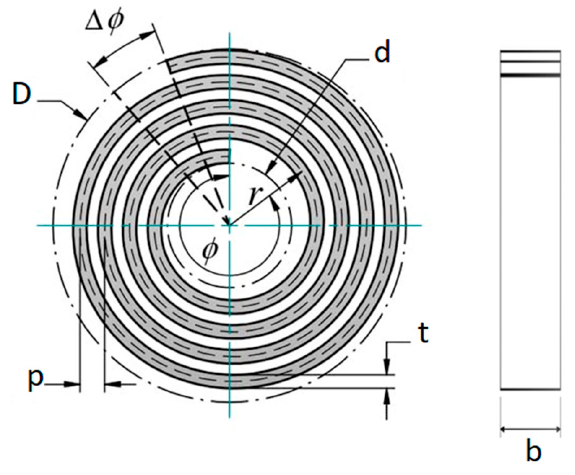
Figure 8. Schematic of a spiral spring .